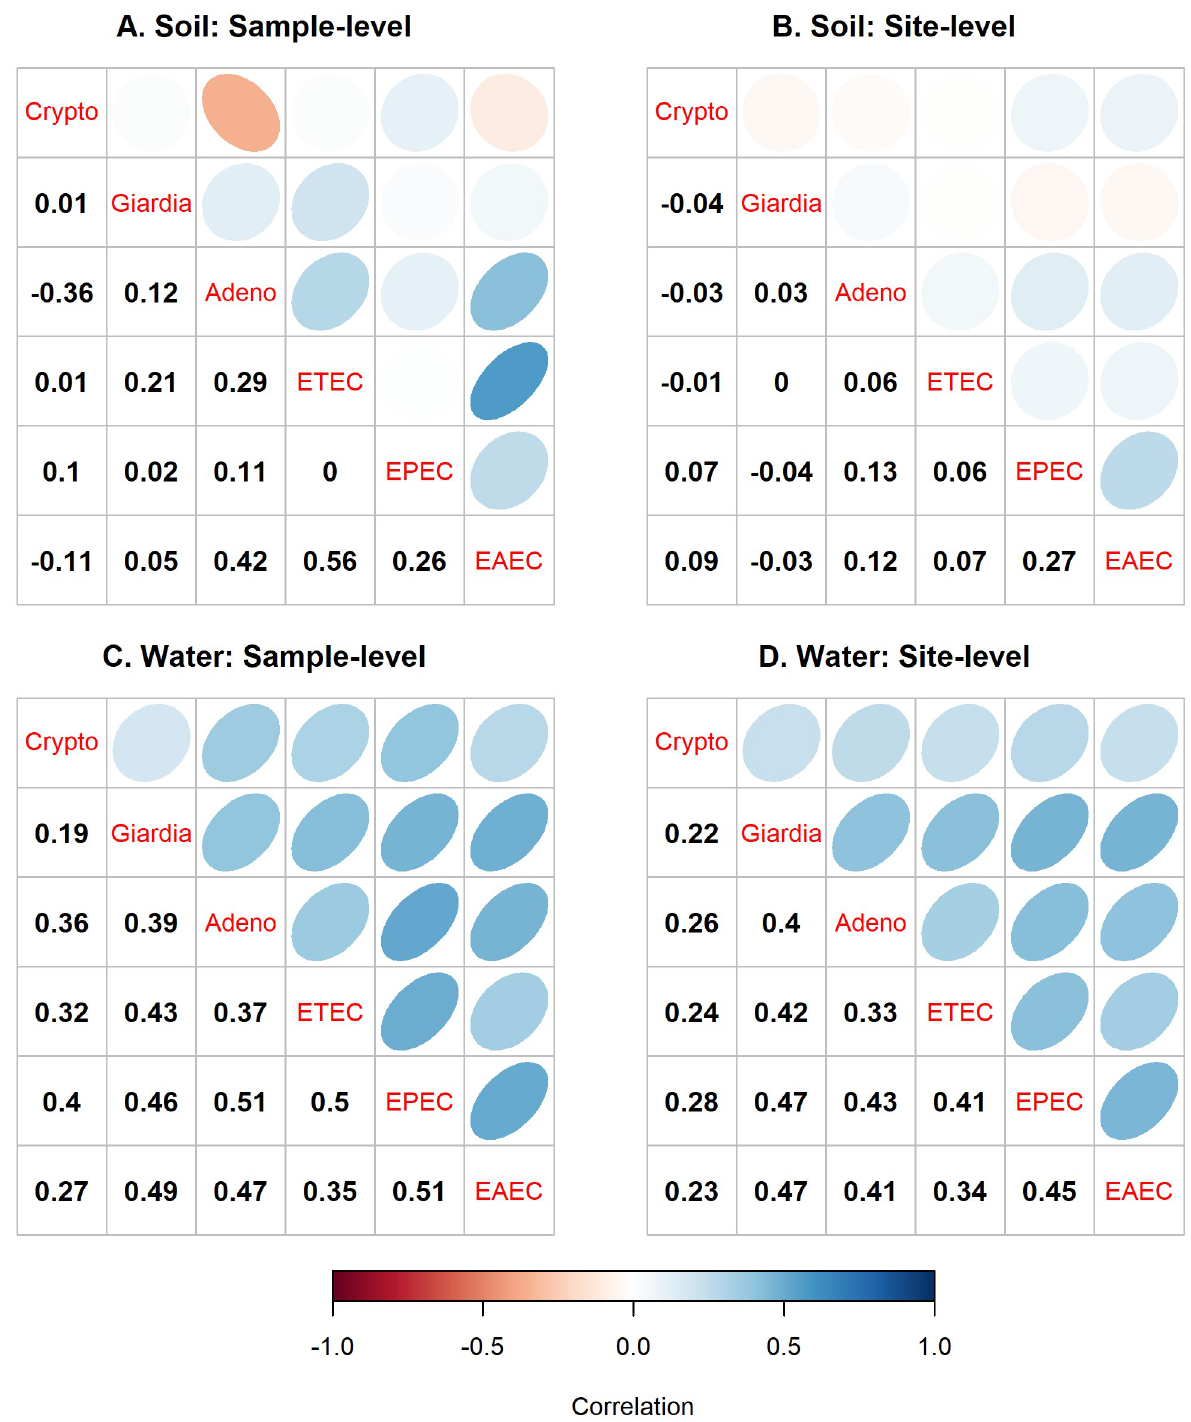
Fig 1. Sample- and site-level correlation in concentration of enteric pathogens in soil and surface water at public areas of Kisumu, Kenya. (A) Correlation in pathogen concentration in soil between all samples. (B) Correlation in pathogen concentrations in soil between multiple samples within a site ( < 25 meter radius area). (C) Correlation in pathogen concentration in surface water between all samples. (D) Correlation in pathogen concentrations in surface water among multiple samples within a site ( < 25 meter radius area). Negative and positive correlation shown in the lower left quadrants of each grid are reflected in orange-red and blue circles, respectively, in the upper right quadrants of each grid. The highest rho indicated by the darkest color and narrowest shapes.